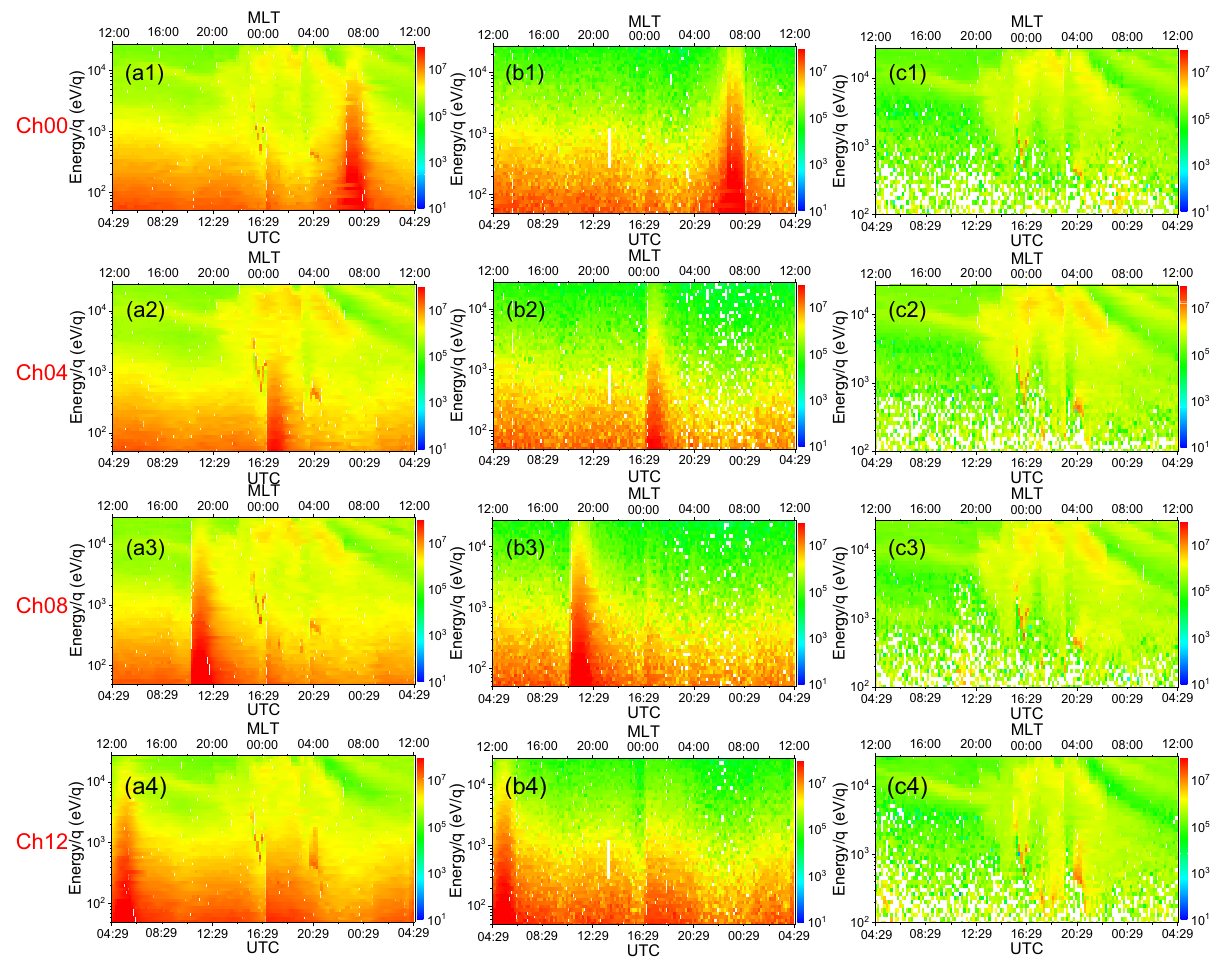
Figure 8: Preliminary results recorded on - orbit by di ff erent azimuth angle channels in a day from 2021 - 09 - 30 to 2021 - 10 - 01. The panels in the left column are the initial data. The panels in the middle column are the UV response and background noise. The panels in the right column are the true ion data obtained by using the initial data to subtract UV response and background noise. ( a1, b1 and c1 ) for Ch00, ( a2, b2 and c2 ) for Ch04, ( a3, b3 and c3 ) for Ch08, and ( a4, b4 and c4 ) for